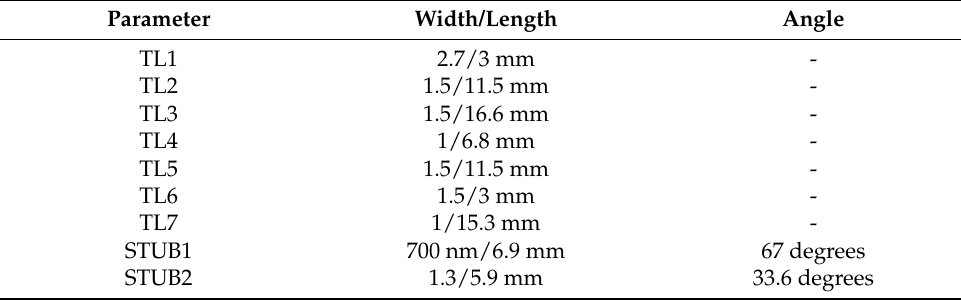
Table 1. Physical parameters of the transmission lines and